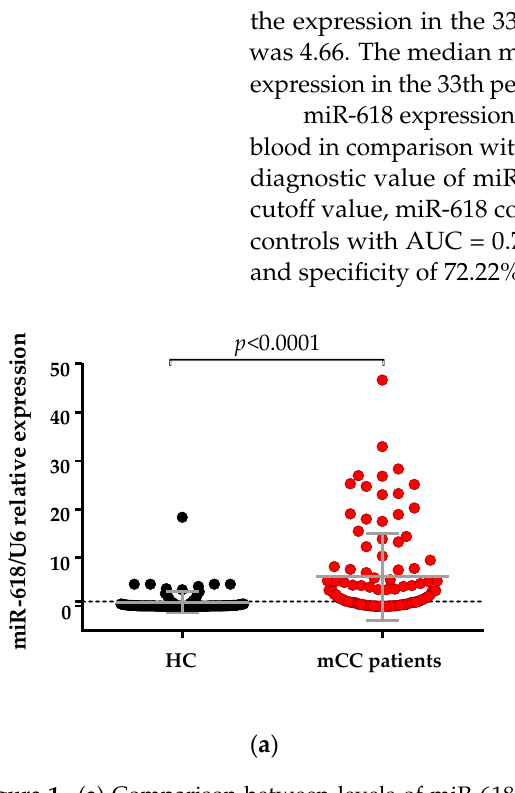
Figure 1. ( a ) Comparison between levels of miR-618 in serum samples from healthy controls (HC) and patients with metastatic colon cancer (mCC) (Mann-Whitney U test, data are presented as mean ± SD). The expression levels were measured using qPCR. U6 RNA was used as an internal control. Relative gene expression was calculated using 2 −∆∆Ct method. ( b ) Receiver operation characteristics (ROC) curve of using miR-618 to differentiate patients with mCC from healthy controls. Area under the ROC curve (AUC) is 0.791, p < 0.0001.